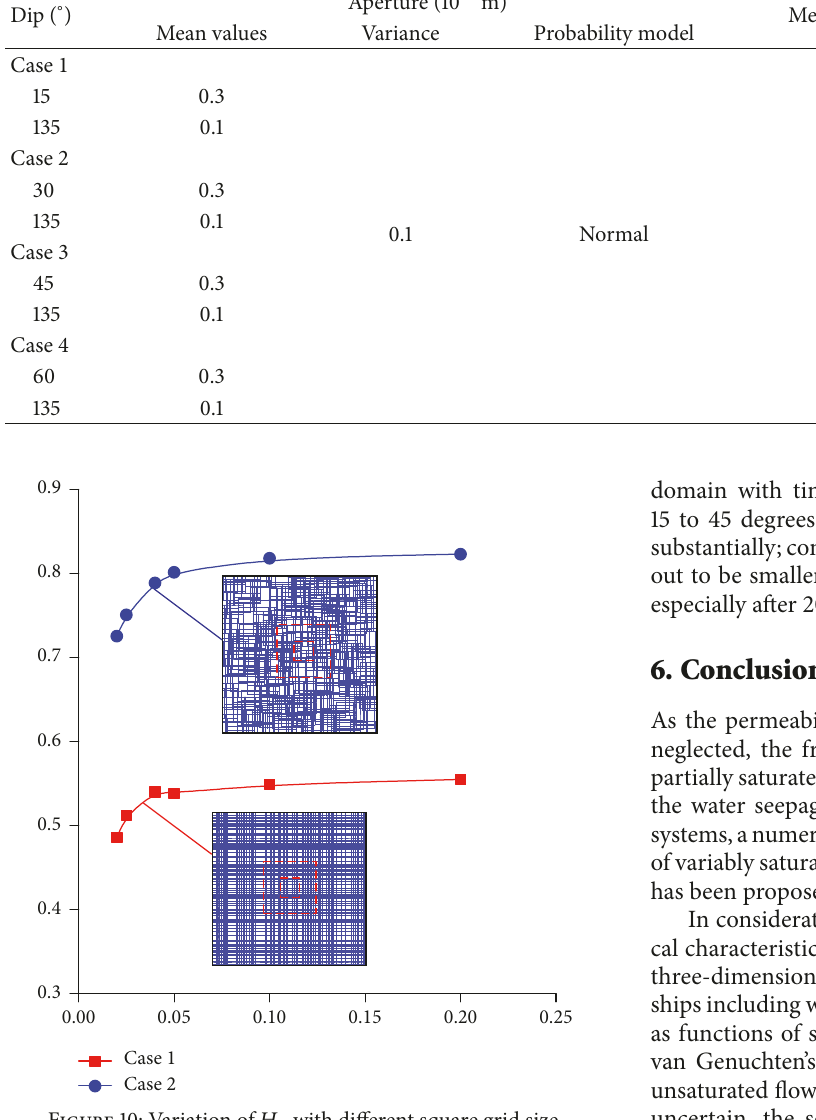
Figure 10: Variation of 𝐻 𝑅 with different square grid